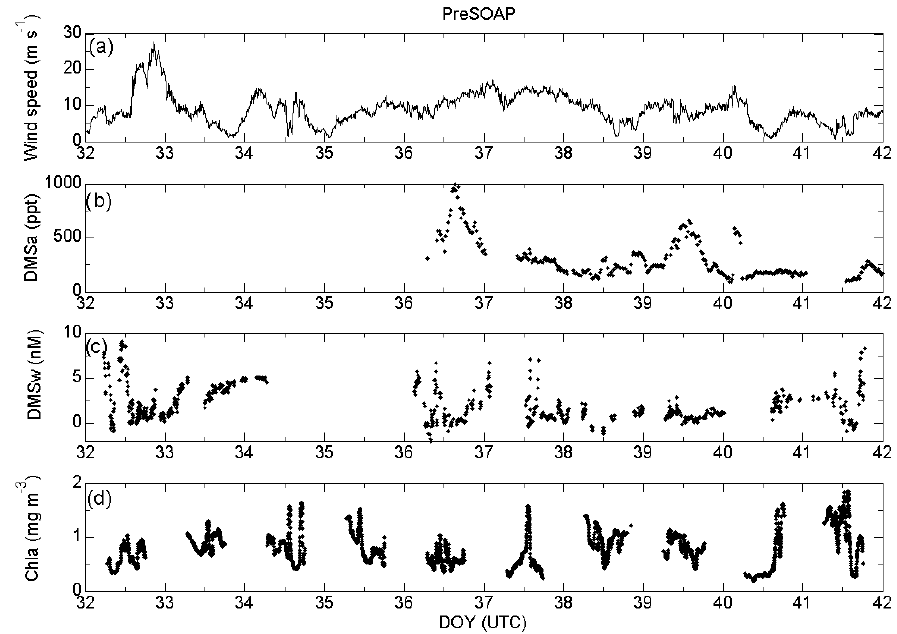
Figure 3. Continuous measurements during PreSOAP of (a) wind speed (ms − 1 ) , (b) atmospheric DMS (ppt), (c) surface water DMS (nmolL − 1 ) and (d) surface chlorophyll a (mgm − 3 ; quenched data